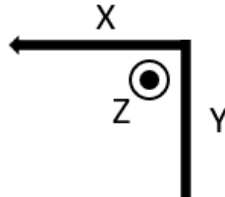
Figure 2. Axial direction of the sensor.